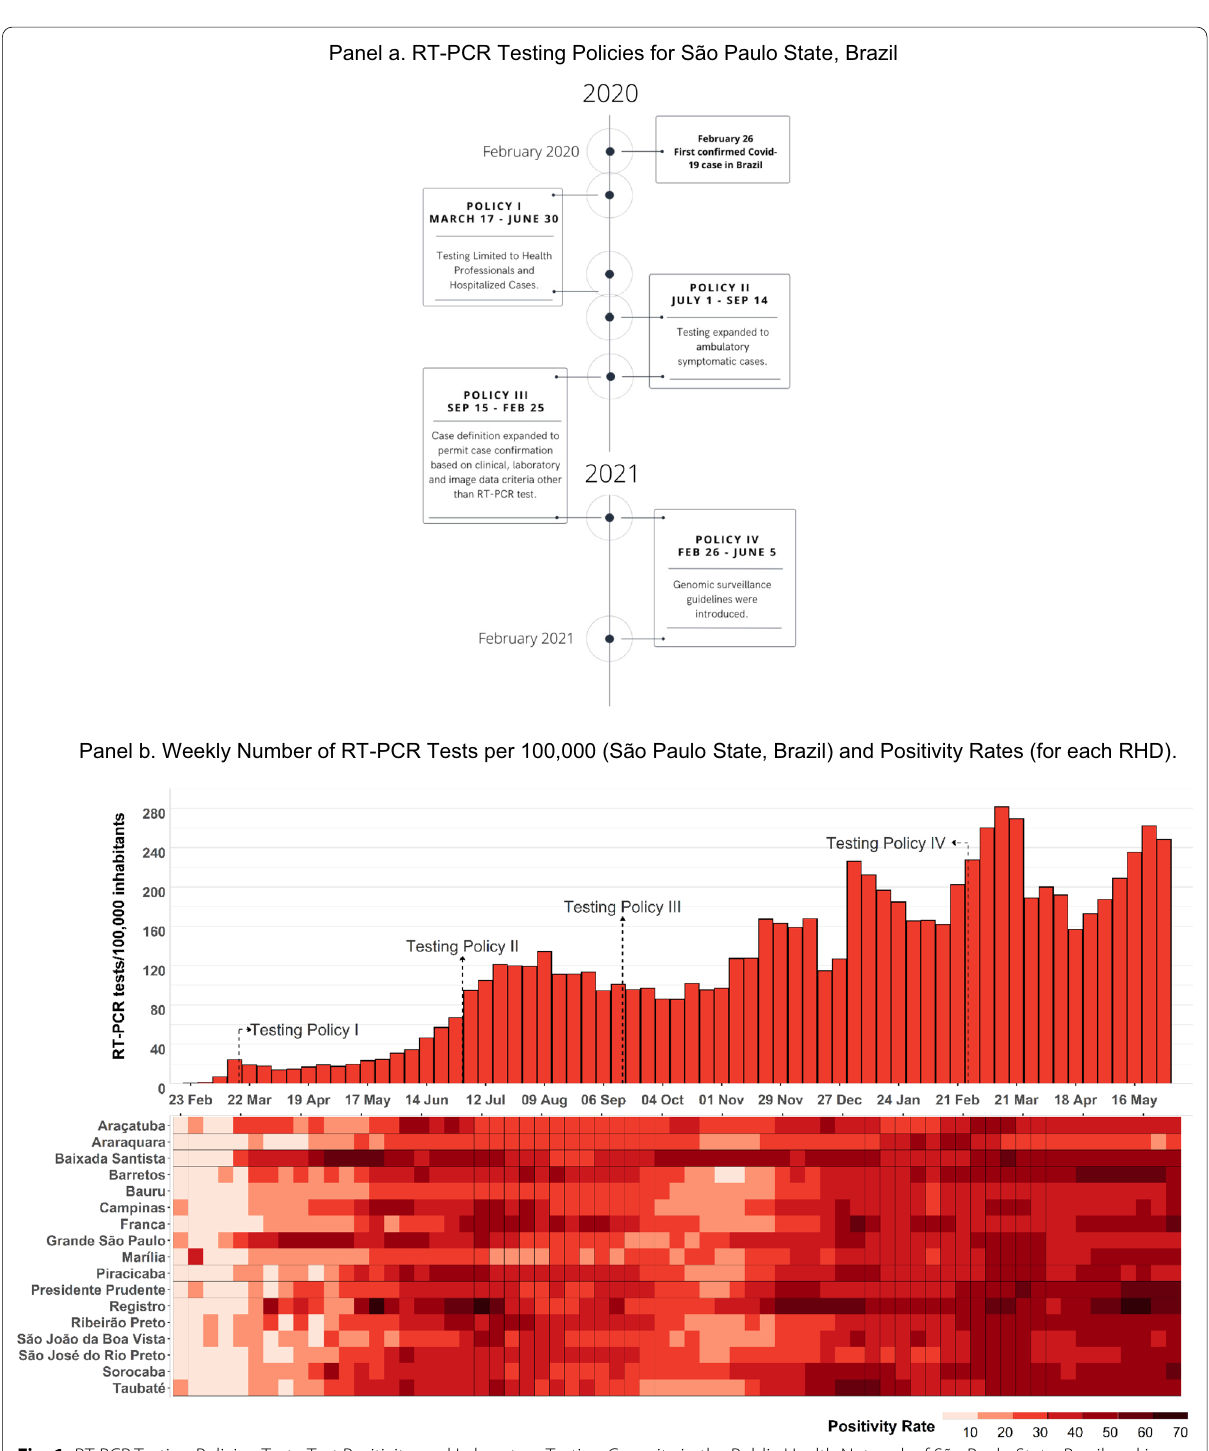
Fig. 1 RT-PCR Testing Policies, Tests, Test Positivity, and Laboratory Testing Capacity in the Public Health Network of São Paulo State, Brazil and